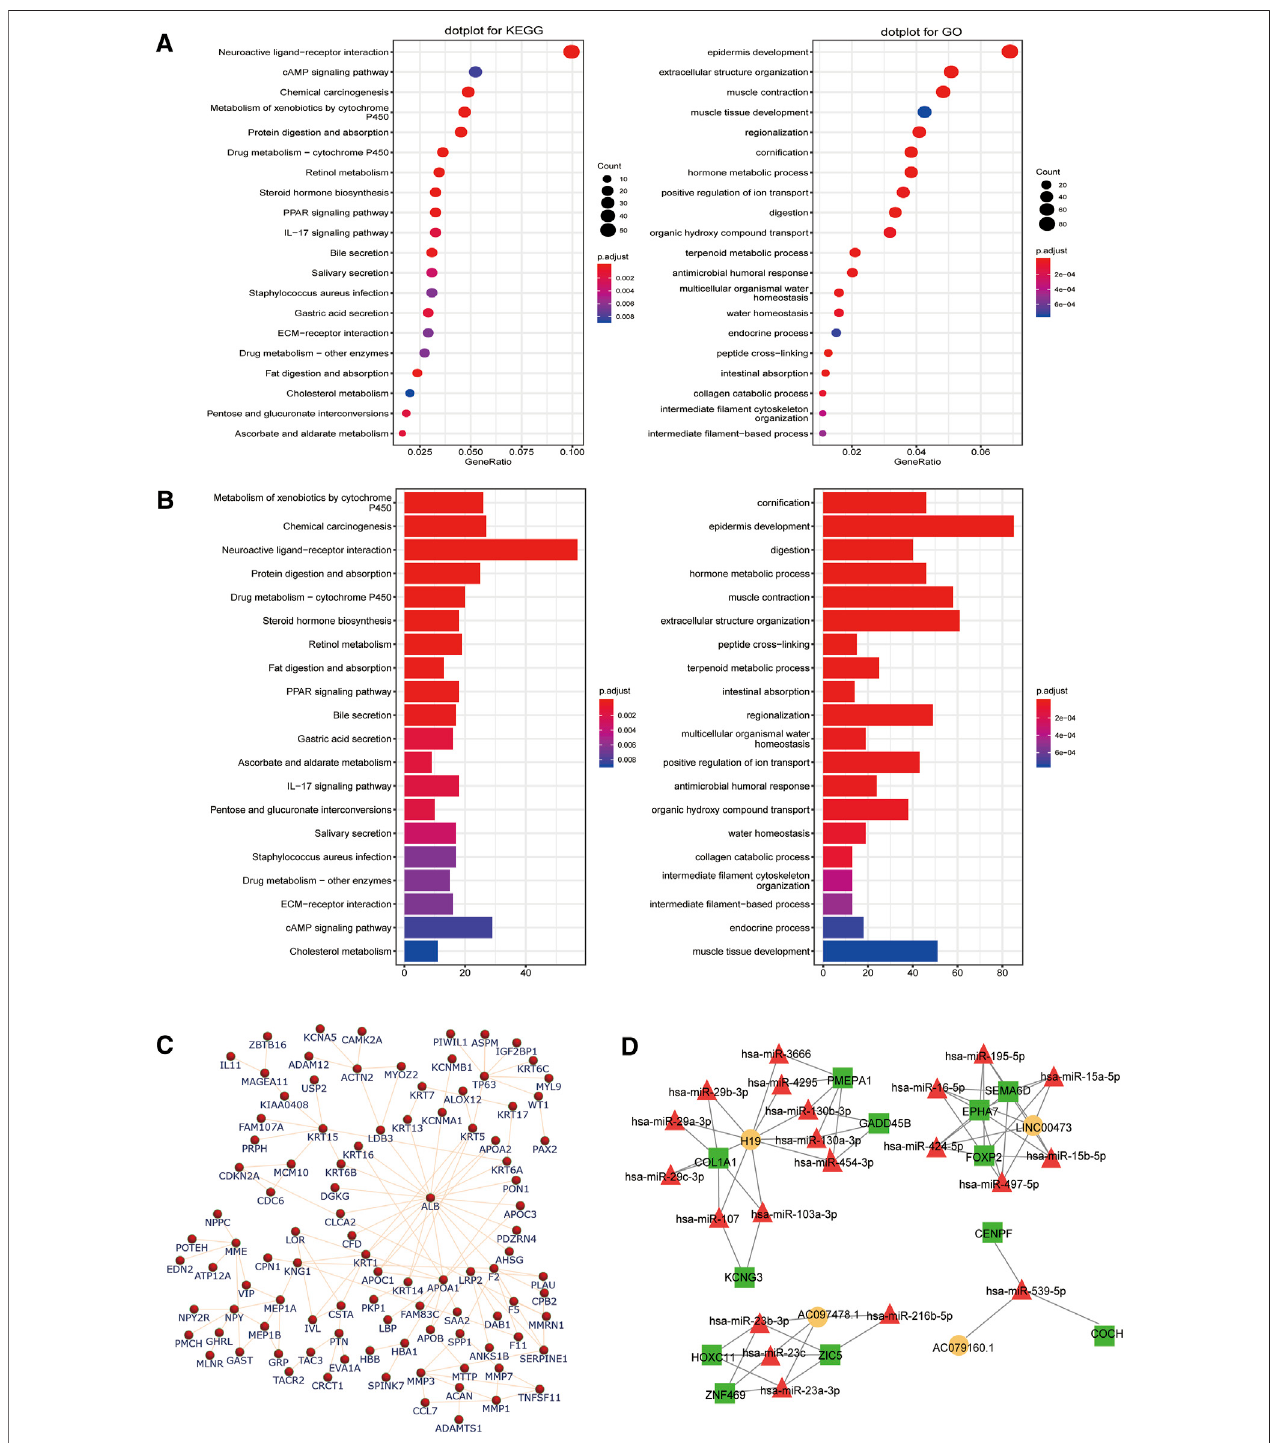
FIGURE 4 | Identi fi cation of key pathways and proteins related to the differentially expressed long noncoding RNAs (lncRNAs) and messenger RNAs (mRNAs) involved in the competitiveendogenousRNA (ceRNA) network.Top 20enriched Kyoto Encyclopedia ofGenesand Genomes (KEGG) pathway and gene ontology (GO) enrichmentanalysisofthedifferentiallyexpressed (A) lncRNAsand (B) mRNAs.ThecountrepresentsthegenesrelatedtotheGOterminKEGGorbiologicalprocesses. (C) In the network diagram, the genes are depicted by the nodes while the interactions are shown by the edges. These protein – protein interactions are based on mRNAs, and the network was constructed using the STRING tool. (D) The lncRNA – microRNA – mRNA network was designed using the correlation analysis between all the DERNAs. Legend: square, mRNA; circle, lncRNA; triangle, miRNA. Orange, red, and green symbols represent upregulated lncRNAs, downregulated miRNAs, and upregulated mRNAs,